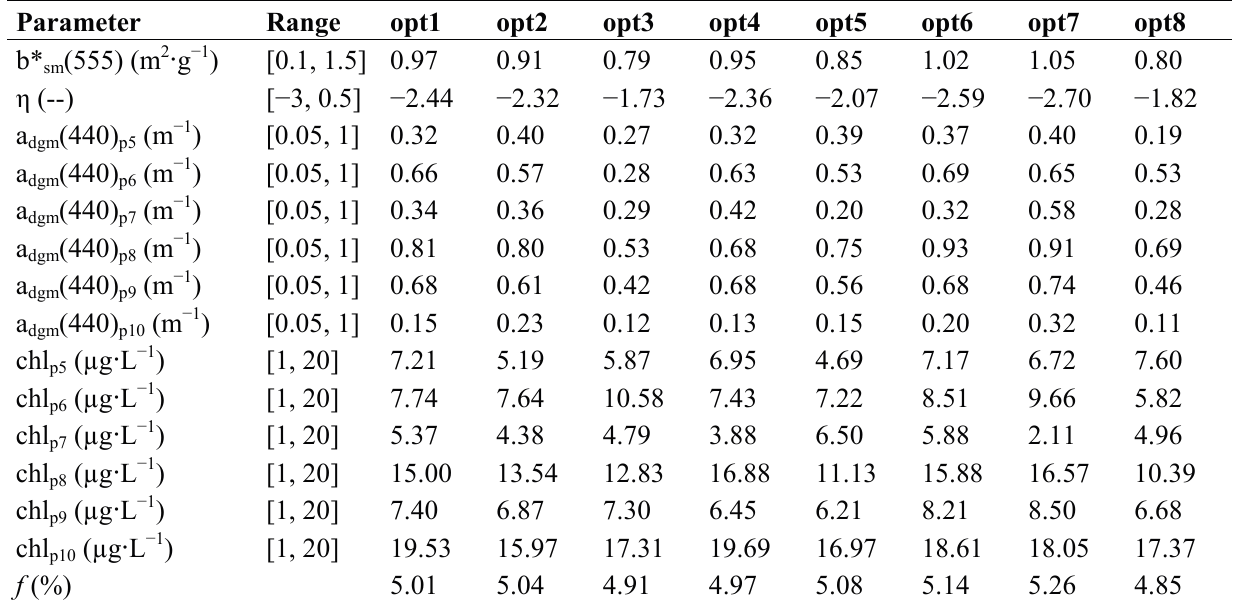
Table 2. Retrieved model parameters for each of the eight optimizations.